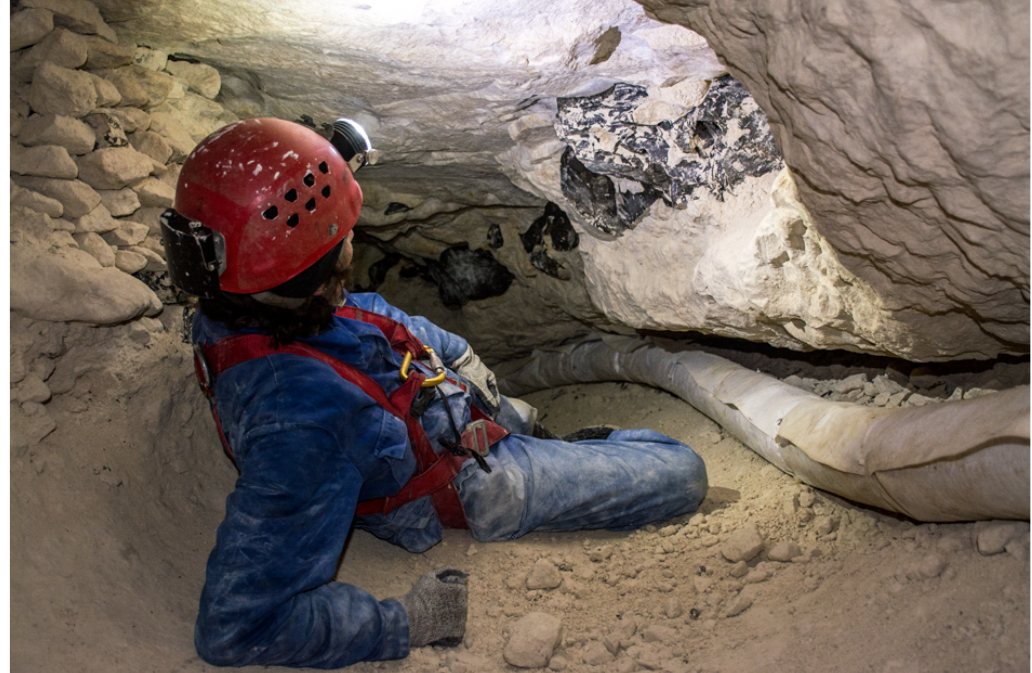
Figure 20. Spiennes, Camp-à-Cayaux. Extraction gallery, east of shaft nr 1 (excavations 1912-1914). Photo by M. Woodbury,